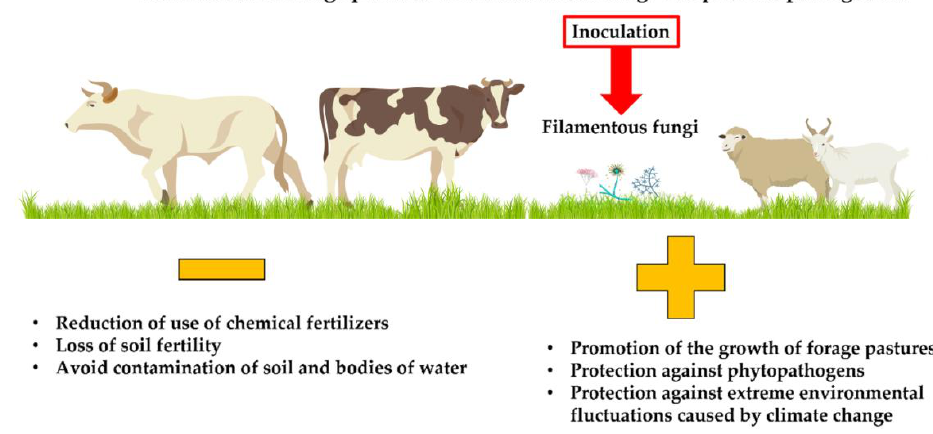
Figure 6. Fertilization of pastures for animal consumption using filamentous fungi.